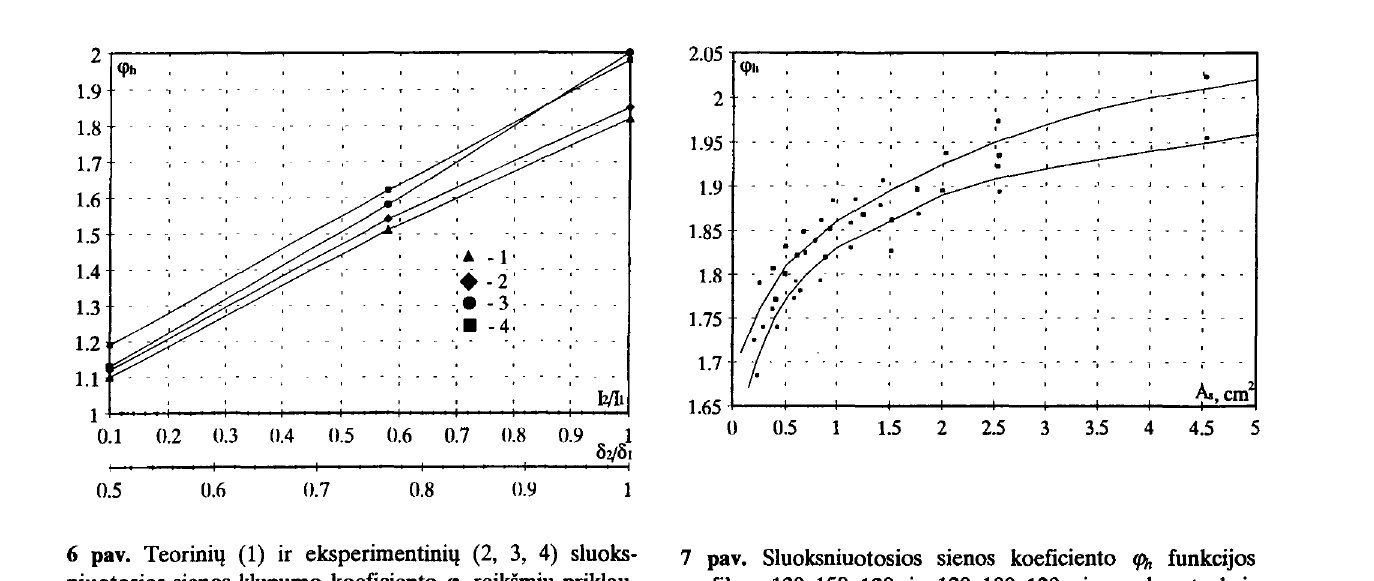
Fig 7. Diagram of buckling coefficient rp,. of layered wall for wall structural cases: 120-150-120 and 120-100-120 mm turint duomenis a pie rysiq bendr'l skerspjUvio plot'! As sienoje arba jos ruoze. Palyginimui buvo paimtos trys tos pacios kreives funkcijos pagal: polinomin~ priklau somyb~, eksponentin~ priklausomyb~, logaritmin~ arba laipsnio funkcij'!.